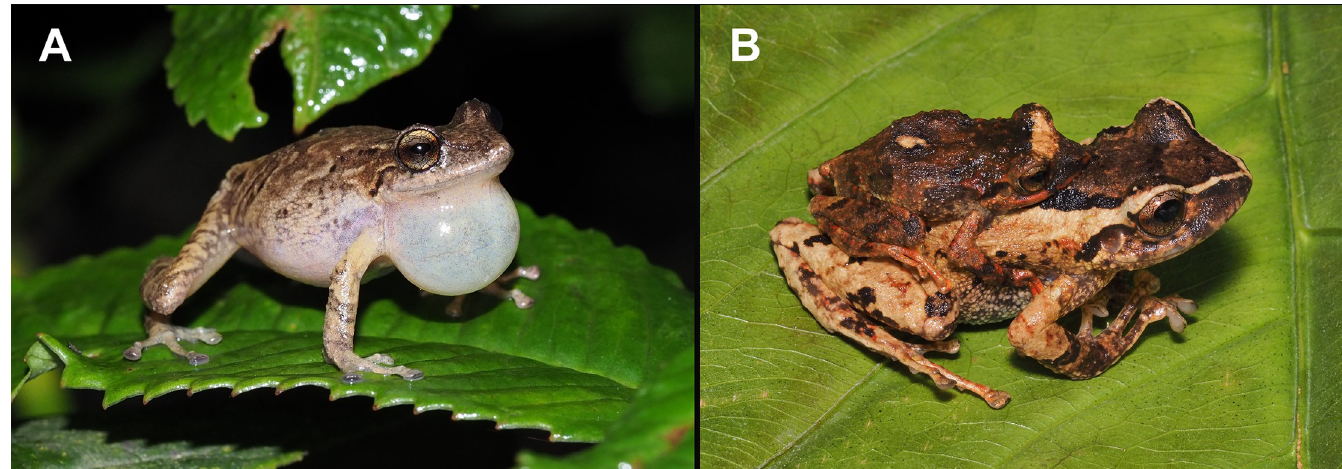
Fig 7. Sexual dimorphism in Pristimantis lojanus sp. nov. A. calling male with the inflated subgular vocal sac (not collected, Cerro Sacama) and B. pair in amplexus (paratypes MUTPL 191 and MUTPL 192, Cristal). dorsum finely tuberculated with scattered larger tubercles (in life the skin tuberculated texture is more evident); skin on venter coarsely areolate to areolate; discoidal fold weak; dorsolateral folds absent; low middorsal fold present; (2) tympanic annulus prominent and tympanic mem- brane differentiated, its length about 45% of the length of eye; supratympanic fold present,